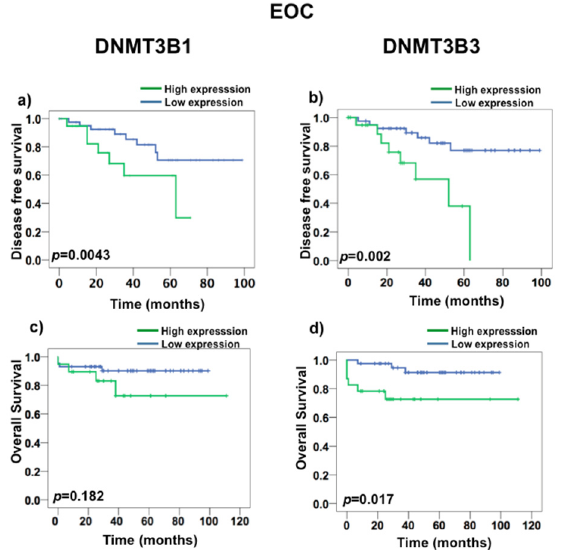
Figure 5. DNMT3B3 overexpression is associated with disease-free survival in ovarian carcinoma (EOC). DNMT3B1 expression in Kaplan–Meyer survival analysis in EOC: ( a ) DFS and ( c ) OS, and DNMT3B3 in EOC: ( b ) DFS and ( d ) OS. The log rank test was used to calculate the significant differences among overexpression (n = 46) versus no overexpression (n = 23) groups.